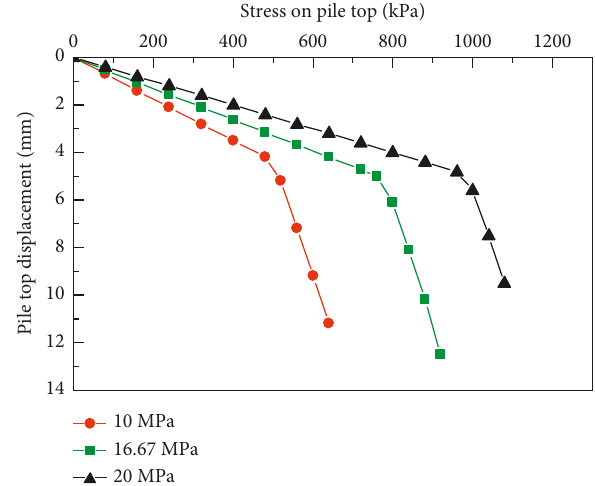
Figure 16: Pile load-settlement curves for different soil